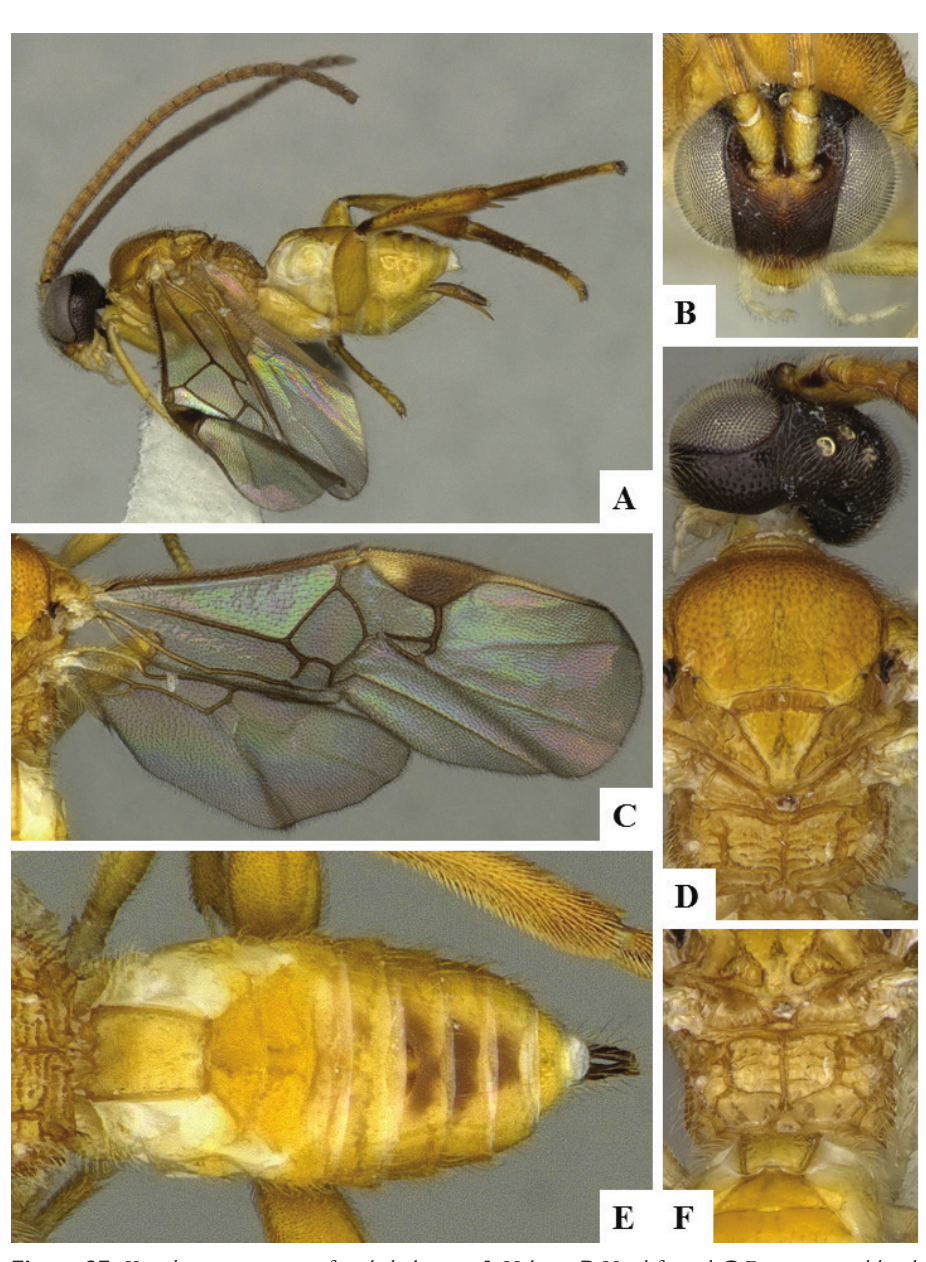
Figure 27. Kotenkosius tricarinatus female holotype. A Habitus B Head frontal C Fore wing and hind wing D Mesosoma dorsal E Metasoma dorsal F